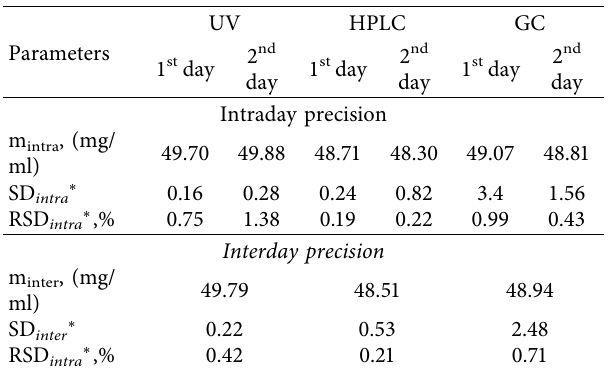
Table 6: Test results of intermediate precision of BAC quantitative determination in the “VIROSAN F”.